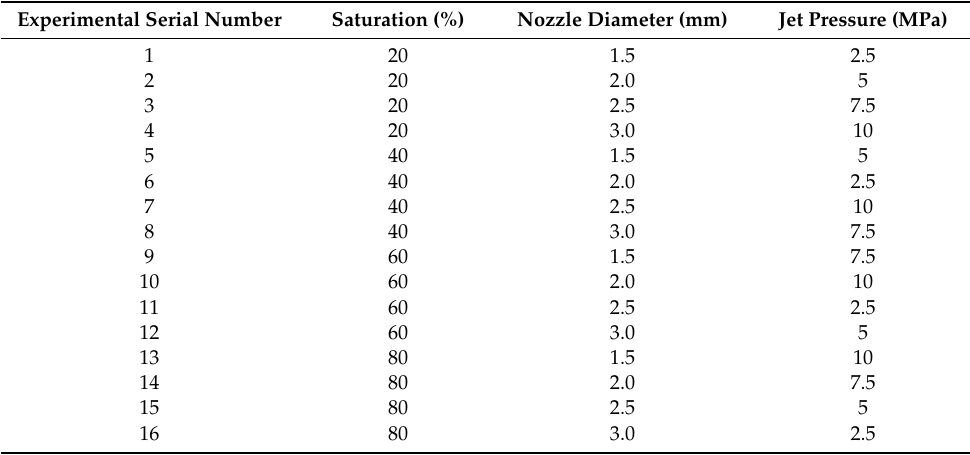
Table 1. Orthogonal design experimental parameters of NGH breaking by water